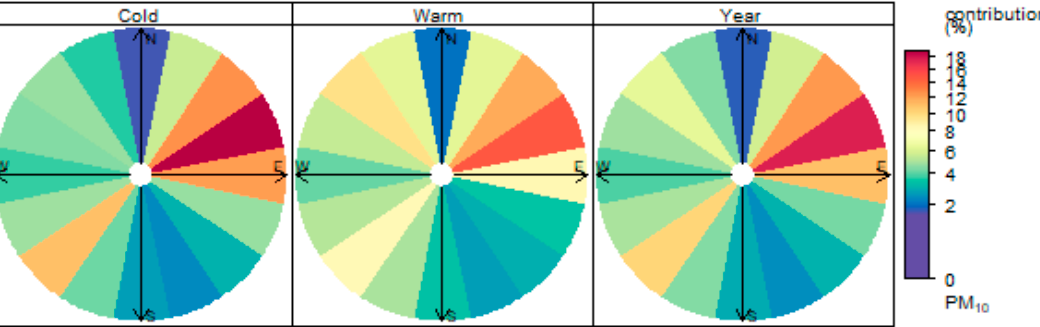
Figure 8. PM 10 concentration roses, V ěřň ovice site, 2011–2020. The average PM 10 concentrations for each daily type of wind in the cold seasons 2011– 2020 (Figure 9) show that the effect of wind direction is similar at both stations. The high- est average PM 10 concentrations in the cold seasons of 2011–2020 are clearly obtained for the NE–E daily type of wind, followed by the E and variable wind direction. The average PM 10 concentrations are also highest in the cold part of the year. The average PM 10 con- centrations in the cold months are 2–4 times higher than the average concentrations in the warm months of 2011–2020 (Figure 10). The average PM 10 concentrations for the entire 2011–2020 period (Figure 11) show that the highest PM 10 concentrations are obtained when the daily wind type is E, NE–E or N–NE.